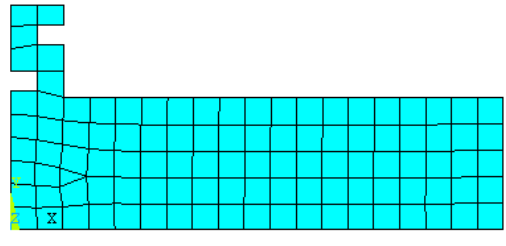
Figure 2. Axial section and grid partition.